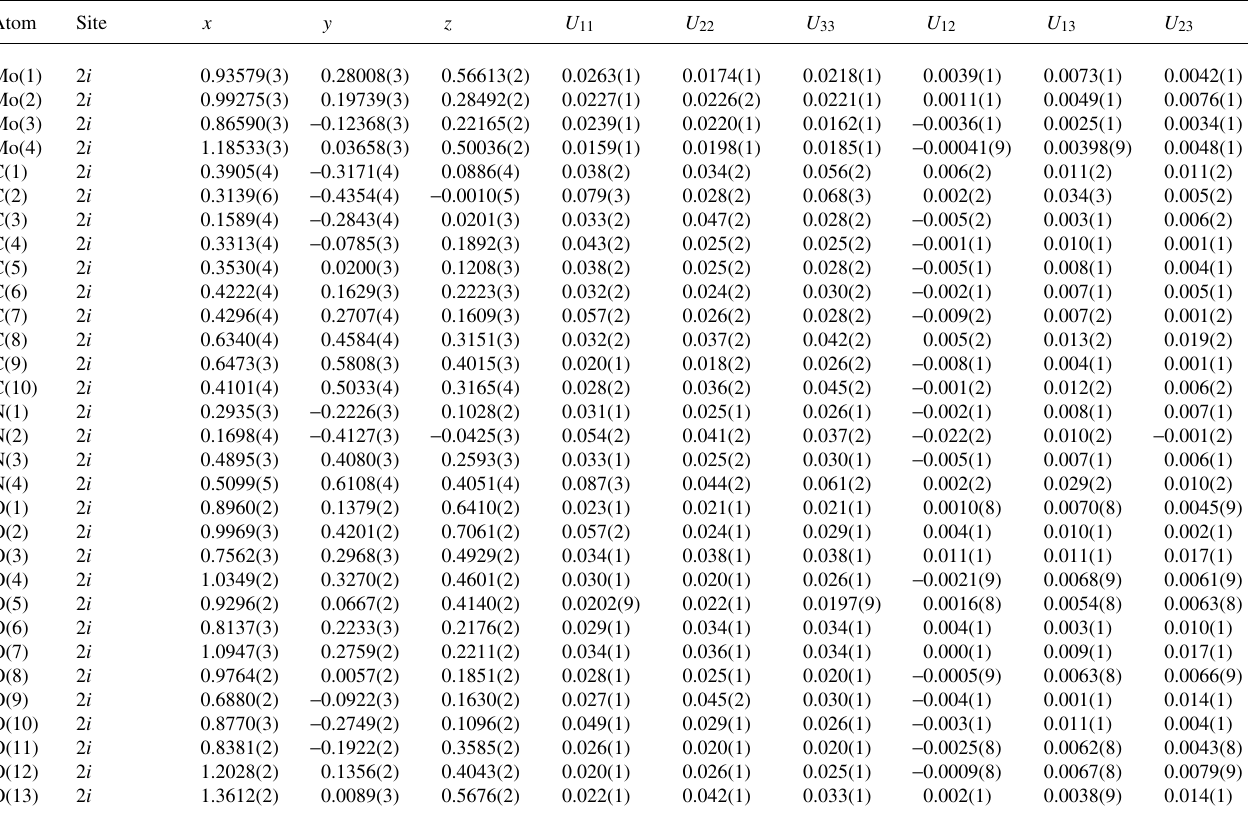
Table 3. Atomic coordinates and displacement parameters (in Å 2 )